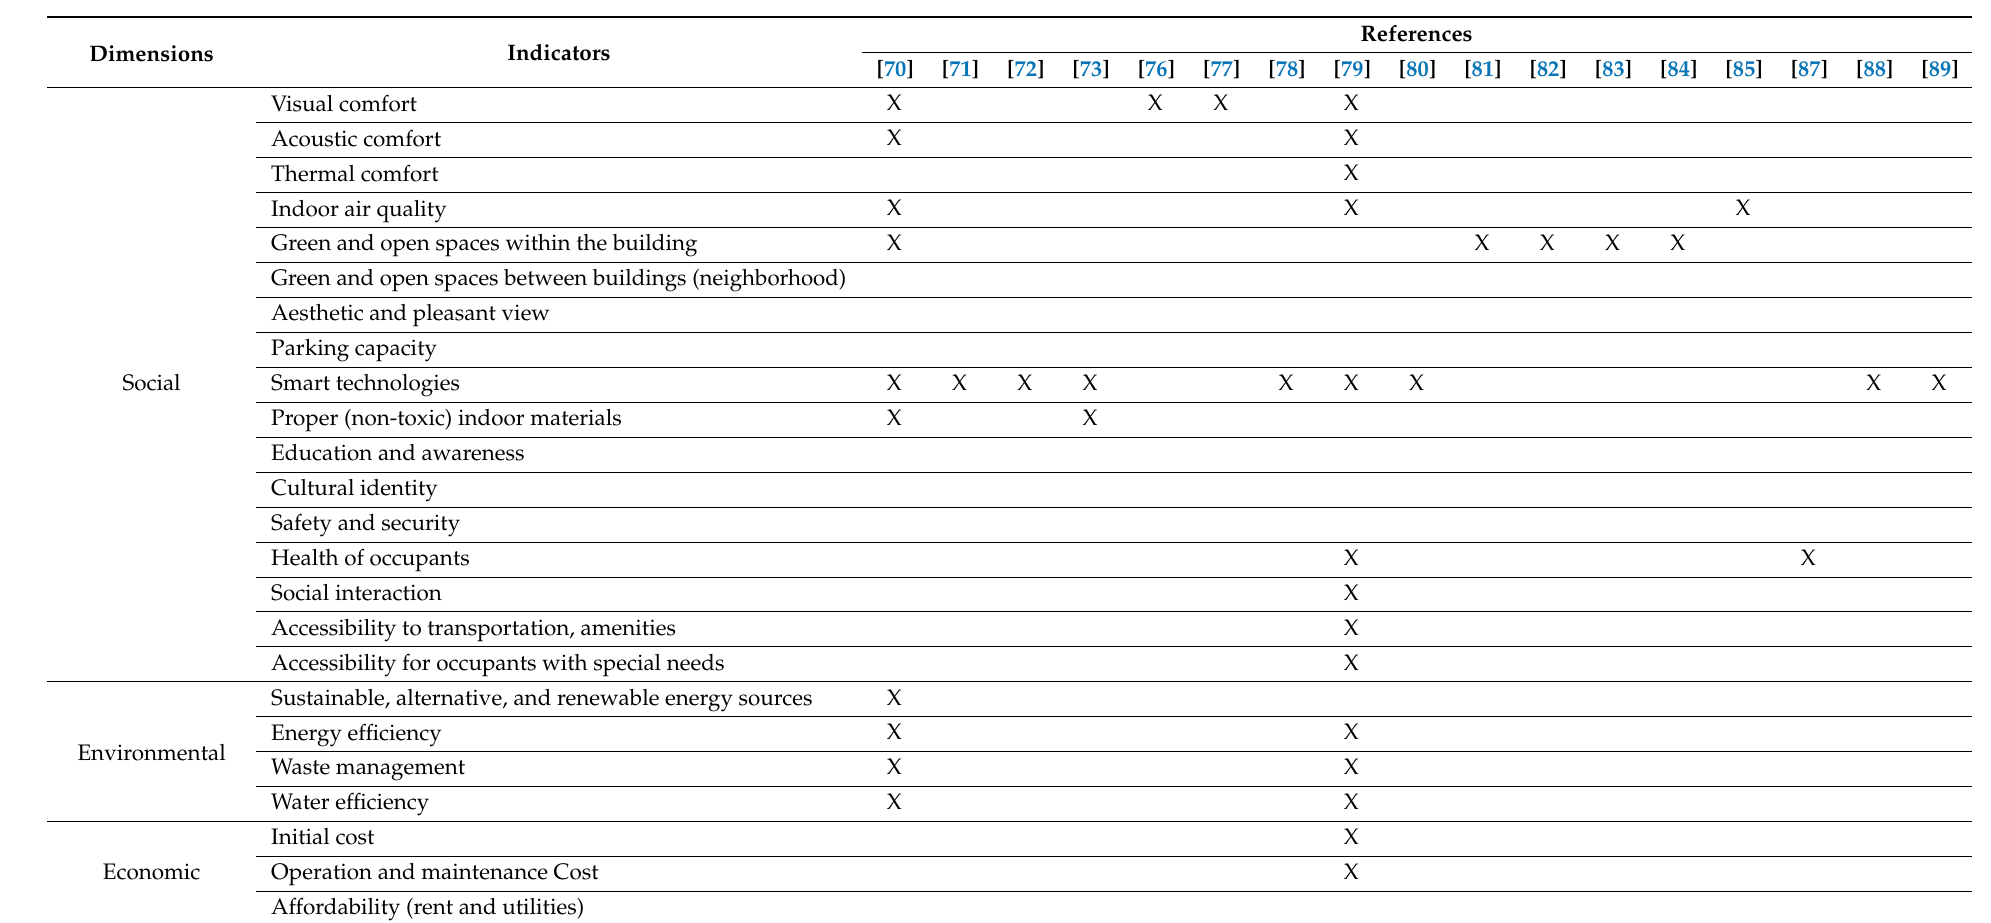
Table 2. Extracted